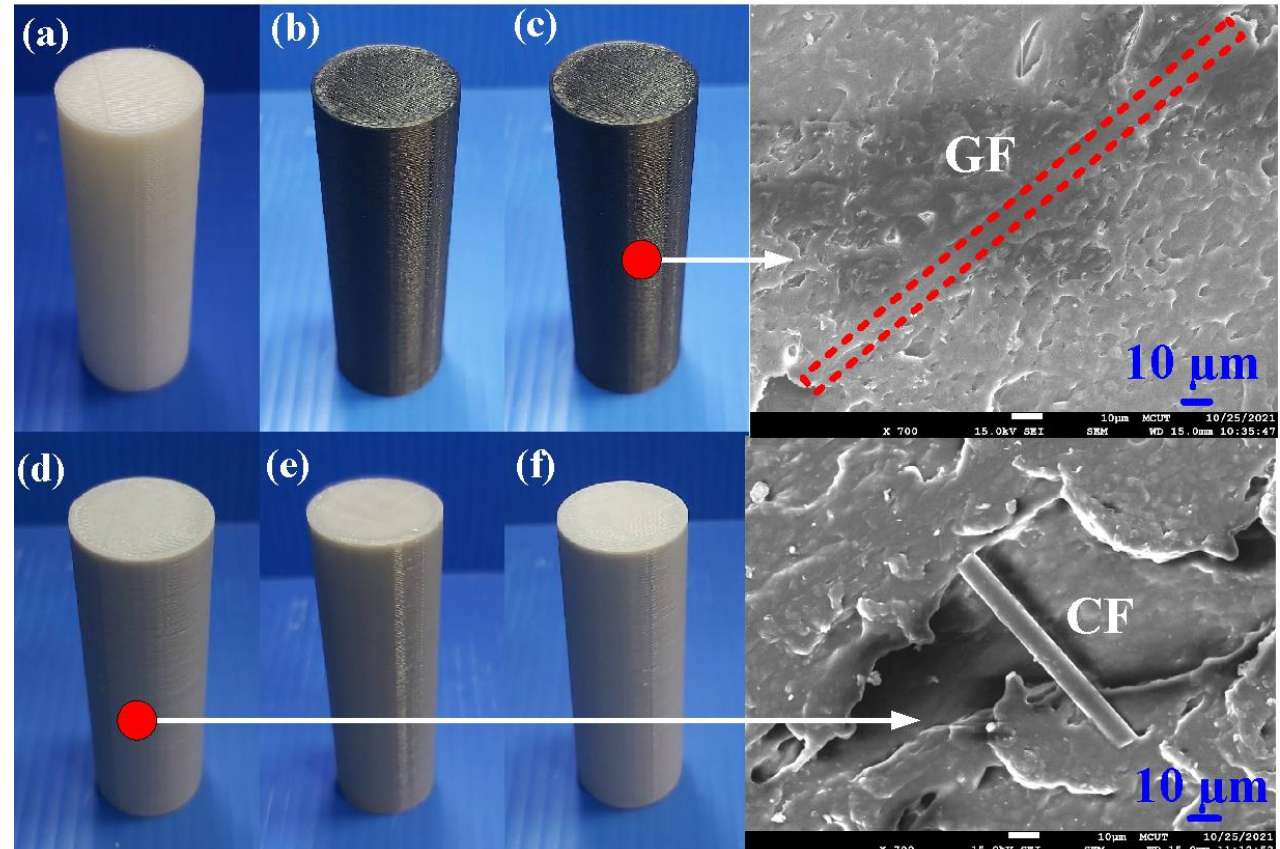
Figure 4. Polymer rods built with ( a ) PLA, ( b ) ABS, ( c ) 10% GF-reinforced PLA, ( d ) 10% CF-reinforced PLA, ( e ) PA, and ( f ) PC feedstock using FDM process.